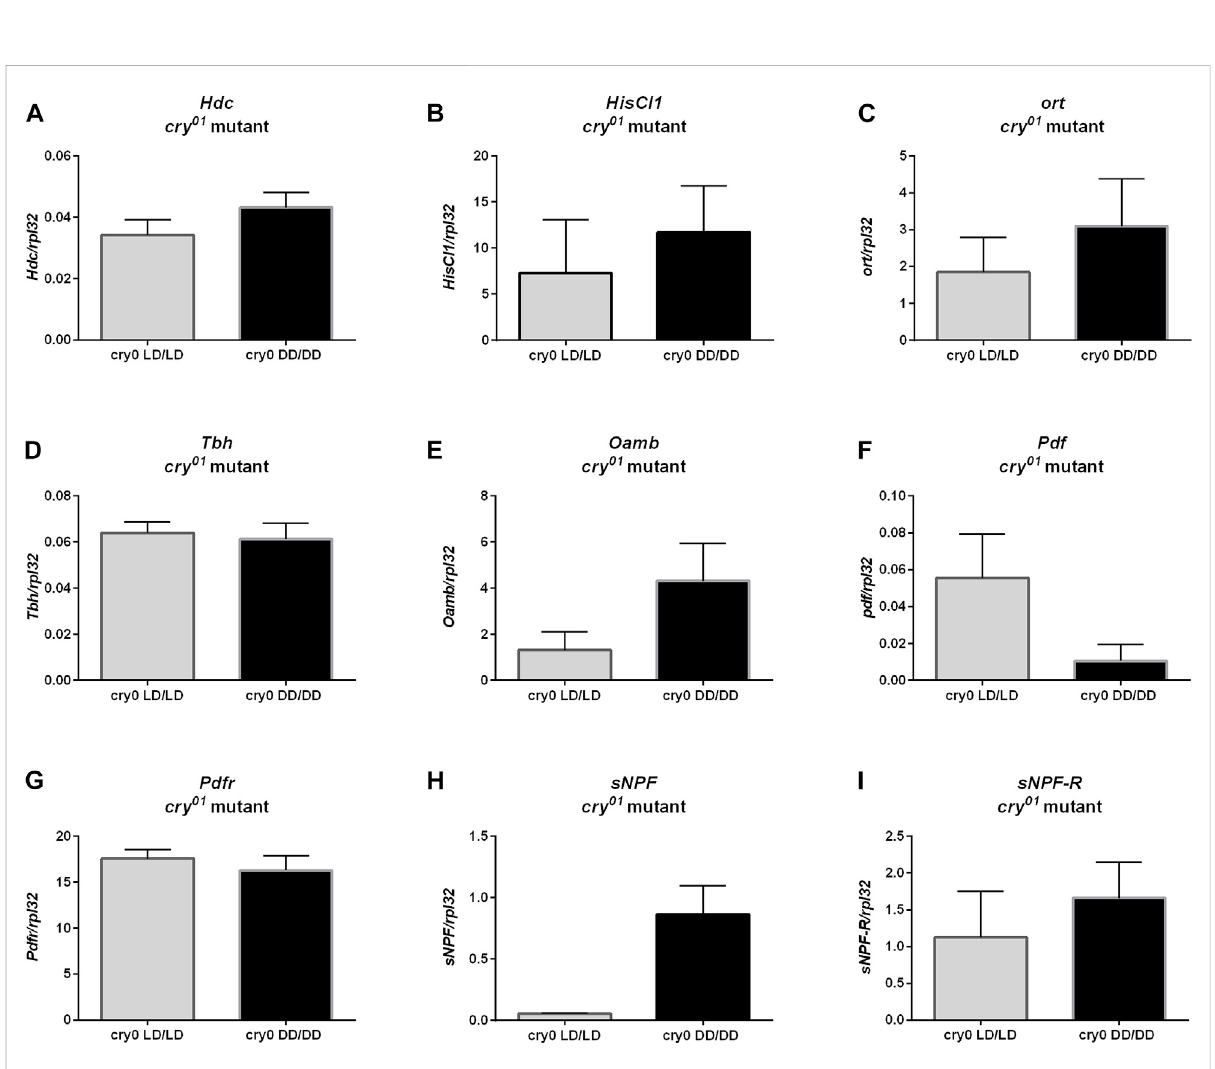
cry 01 mutants does not show changes in neurotransmitters signaling. mRNA of genes coding (A) Hdc , (B) HisCl1 , (C) ort , (D) Tbh , (E) Oamb (F) Pdf , (G) Pdfr , (H) sNPF and (I) sNPF-R did not differ between groups maintained in LD12:12 and darkness during early life. N = 5. Mean ±